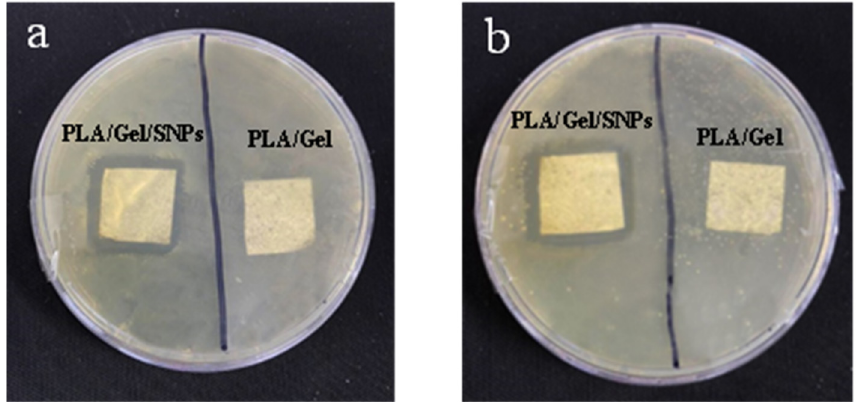
Figure 8. ( a ): Diffusion test for antibacterial activity of PLA/Gel/SNPs and PLA/Gel on S. aureus . ( b ): Diffusion test for antibacterial activity of PLA/Gel/SNPs and PLA/Gel on E. coli .